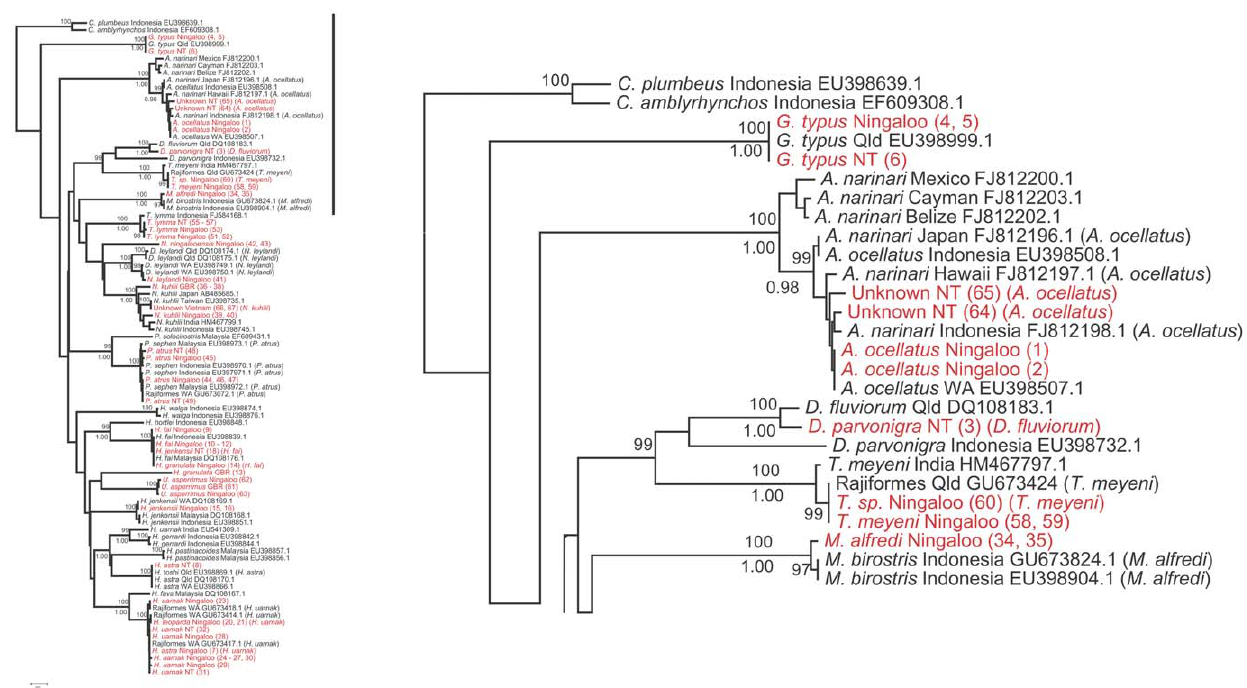
Figure 1. Phylogenetic relationship of rays Part I. Reduced view of the neighbour-joining tree based on COI sequence data using Kimura-two- parameter substitution model (left); the first part of the tree (right). Names in red are the sequences obtained in this study, the corrected nomenclature is in () and given in Table S2.